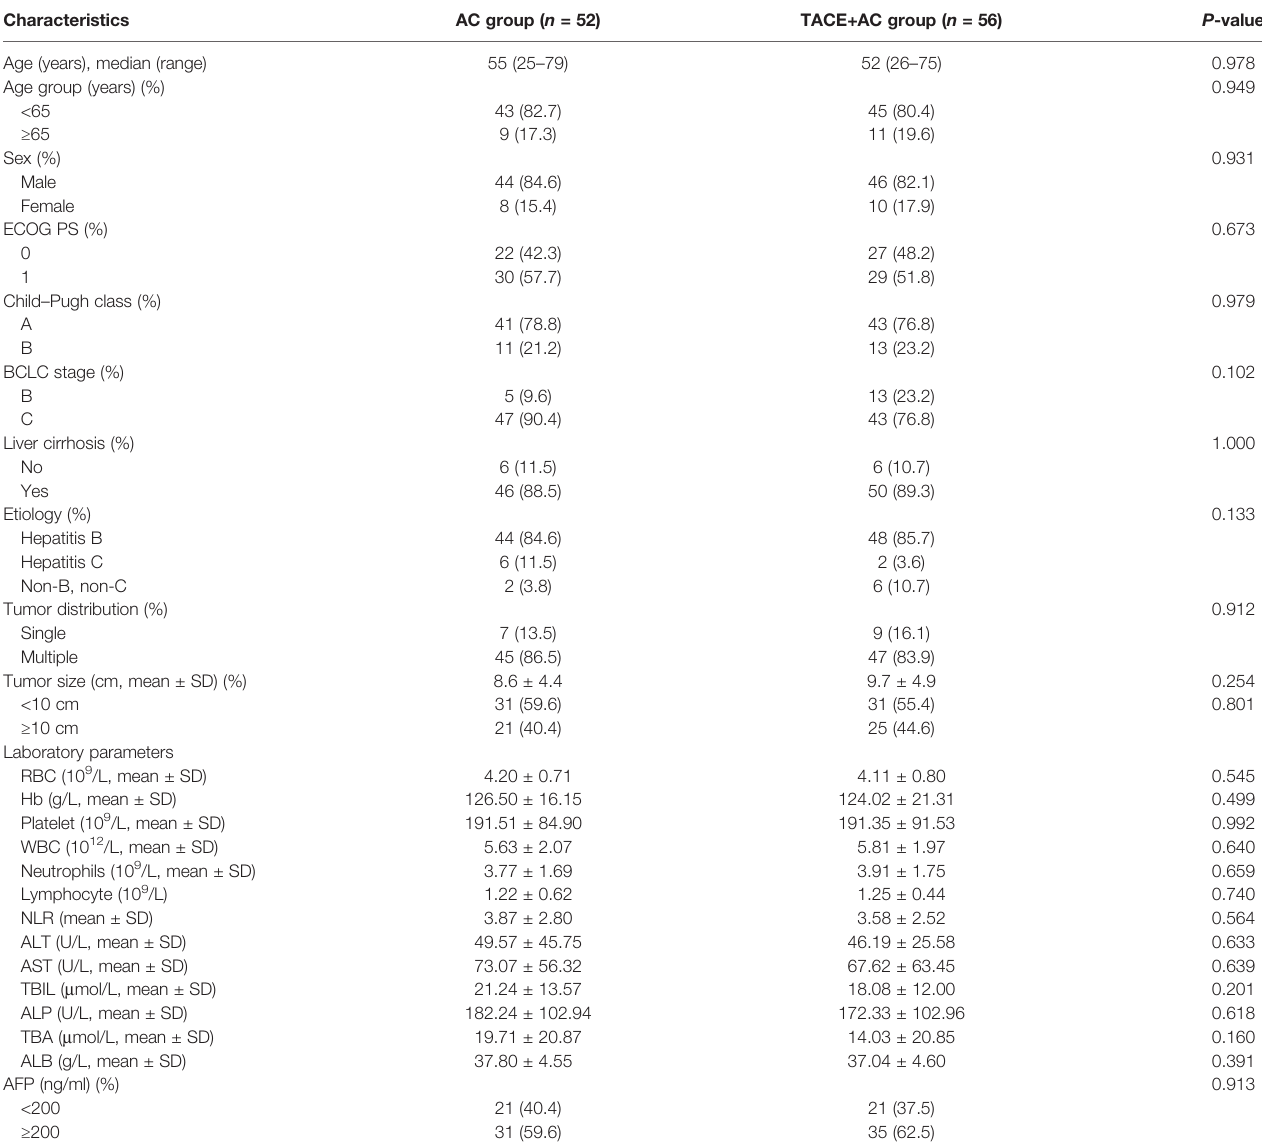
TABLE 1 | Patient characteristics at baseline.